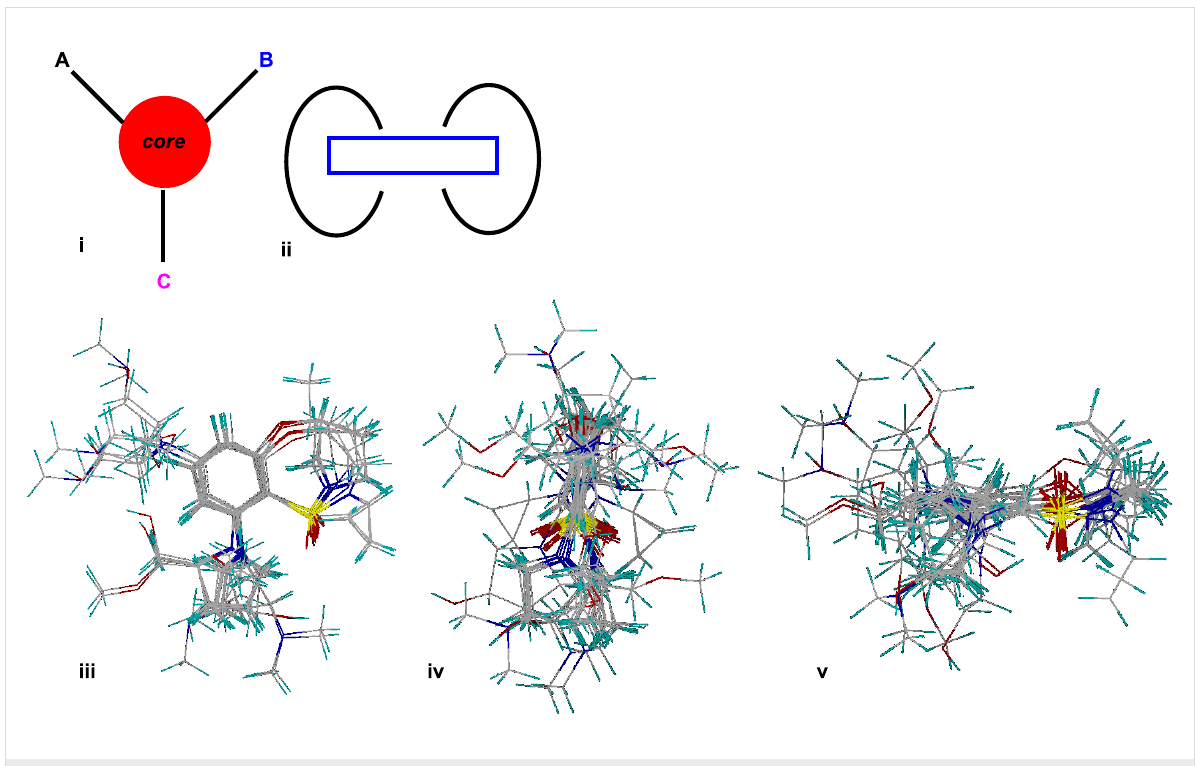
Figure 3: (i) Simple cartoon of the library compounds, with a core of MW ~ 80, based on Lipinski’s rules (MW < 500), and comprising three substituents, each having MW < 140, to establish different functional groups. (ii) This cartoon demonstrates that the substituents extend out of the core in a circular motion. (iii) Overlay images exhibiting the common core in these 80 compounds. (iv) and (v) both overlay images revealing that the substituents are extending outwards in the circular motion as mentioned in